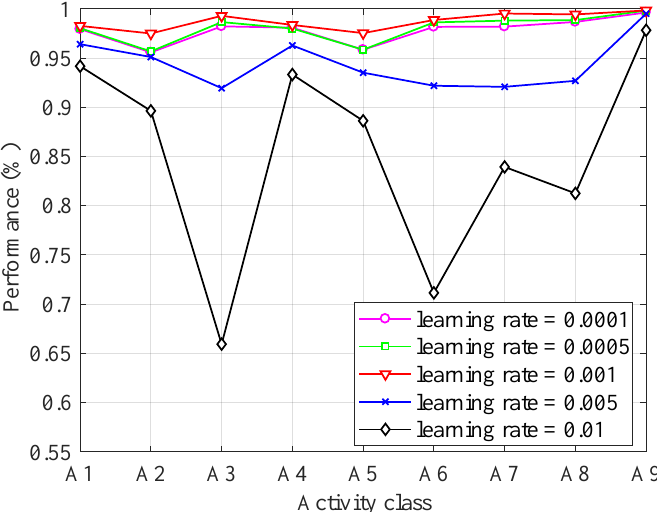
Figure 6. The performance with different learning